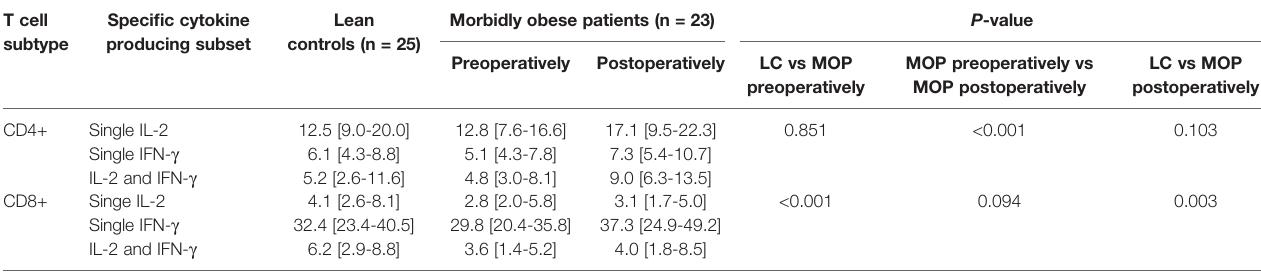
TABLE 2 | Maximal cytokine producing capacity by T cells.